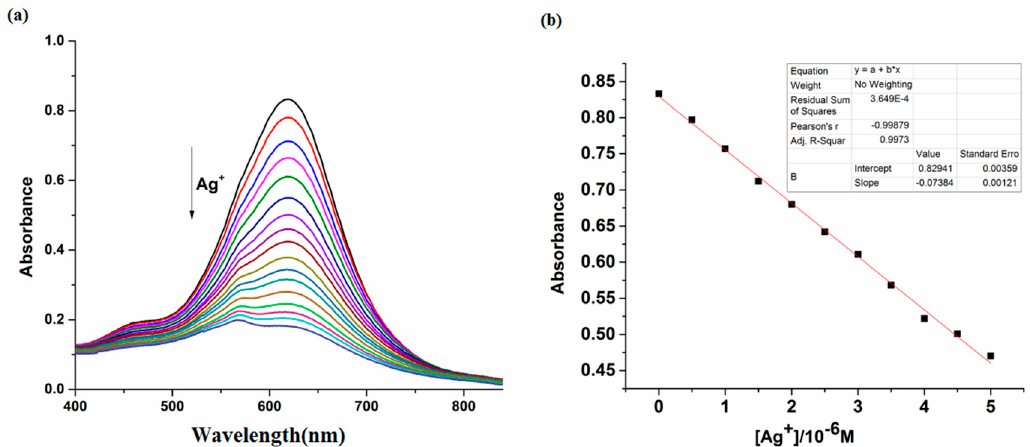
Figure 2. ( a ) The absorbance spectra of QCy (2.5 μ M) at different concentrations of Ag + (0.0 – 7.0 μ M) in EtOH/PBS (1:9 v/v, pH = 7.0, 10 mM). ( b ) The linear relationship between the absorbance intensity and the concentration of Ag + .